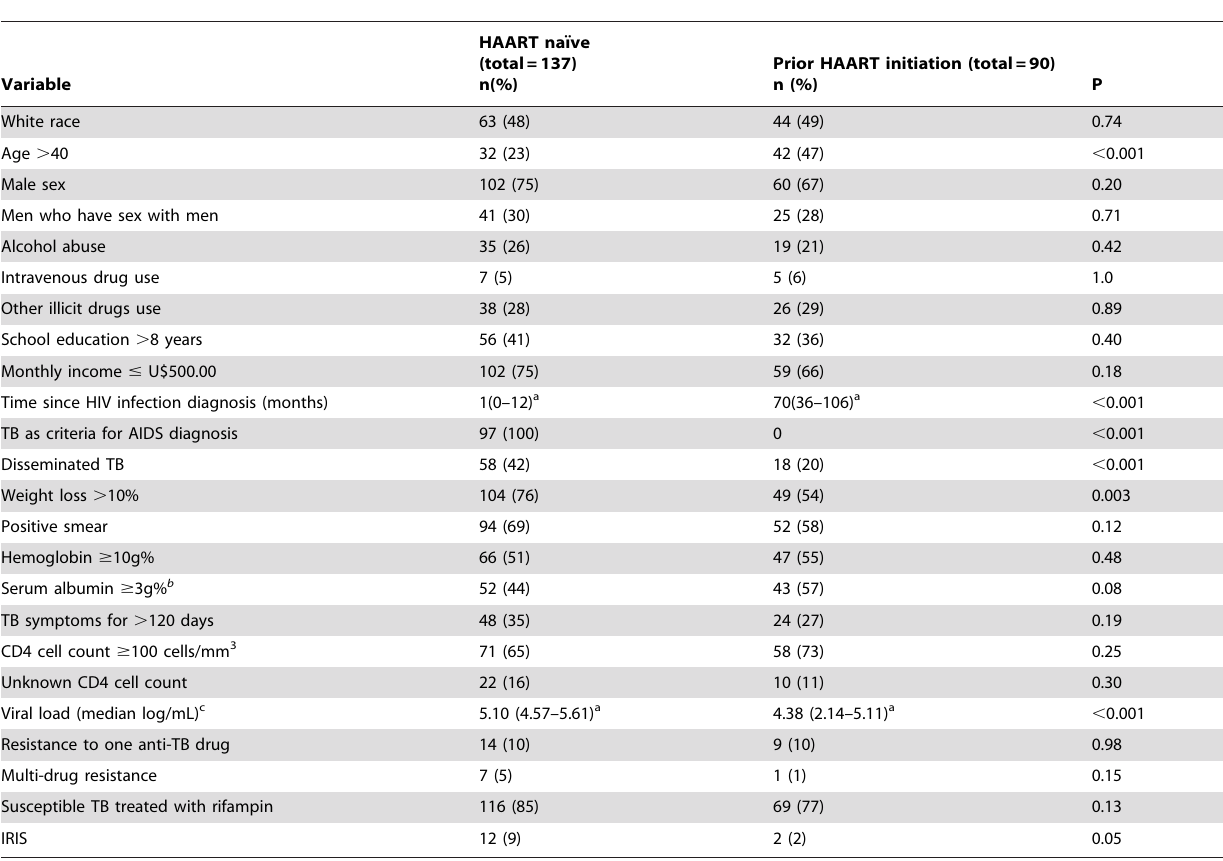
Table 4. Distribution of Variables According to HAART Status at Baseline.